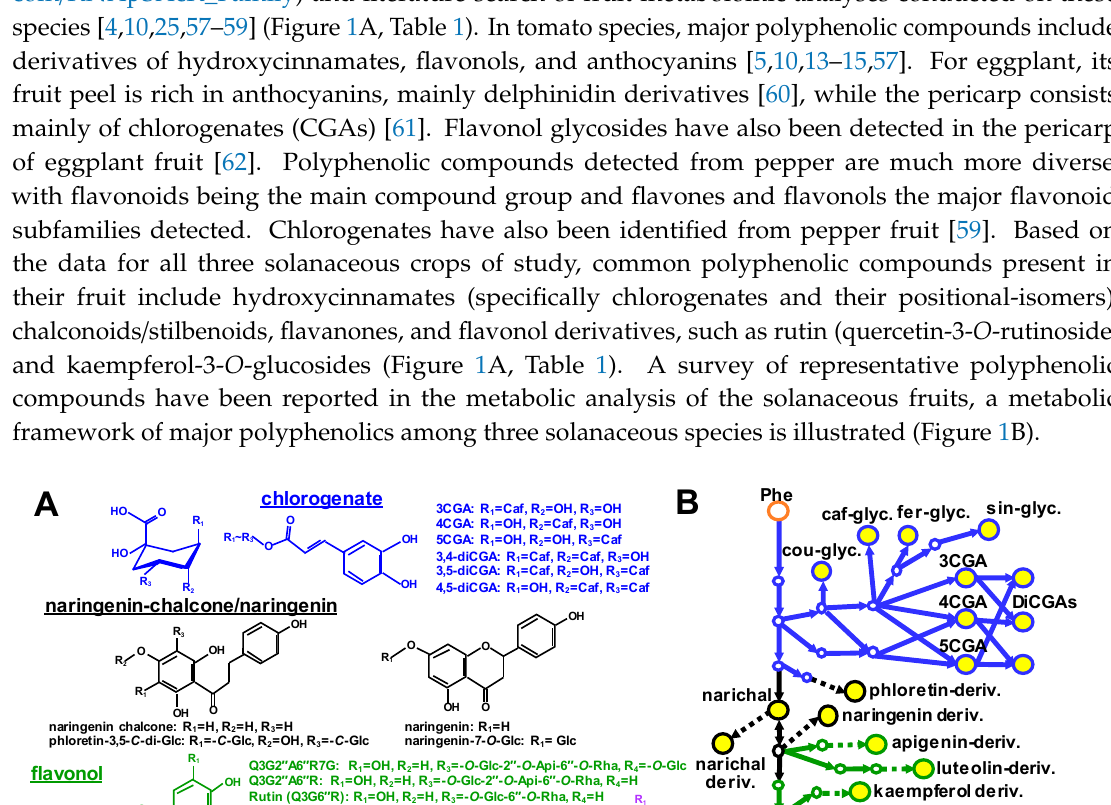
resulting in changes in fruit flavor, texture, aroma, hardness, nutrient composition, and color